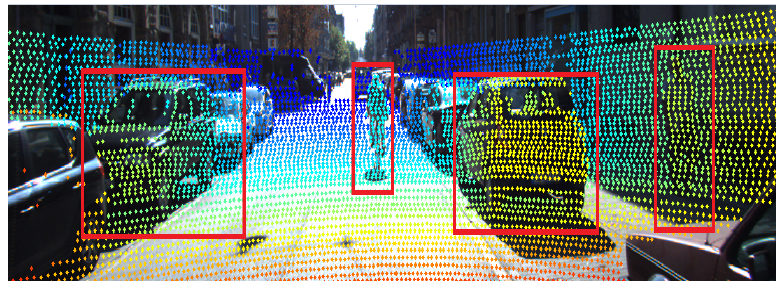
Figure 7. Result on hypothesis generation phase.